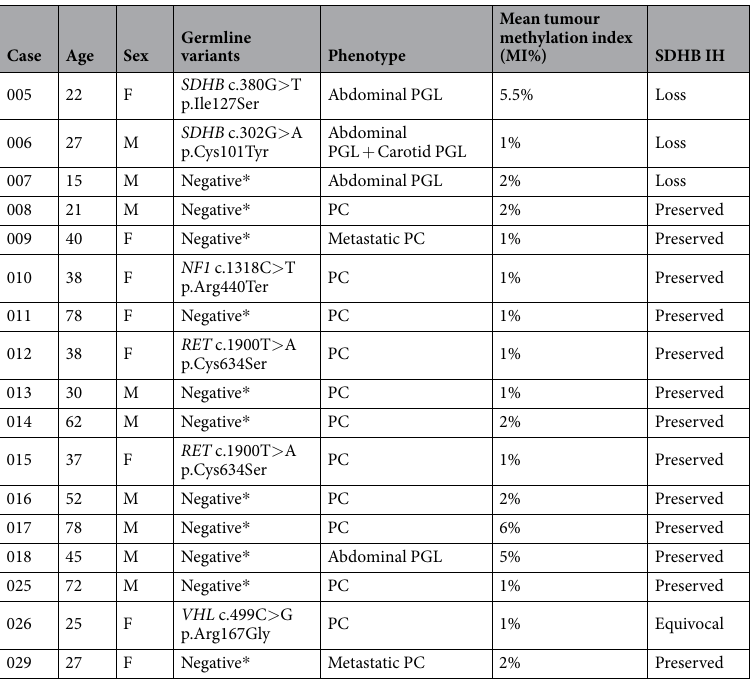
Table 2. Clinical and molecular profile of PPGL study participants. * MLPA